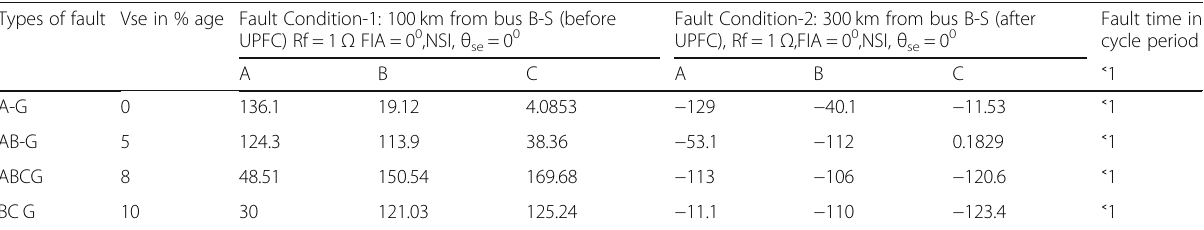
Table 4 DSE performance variation, fault time of variation in V se at θ se = 0 0 of UPFC Types of fault Vse in % age Fault Condition-1: 100 km from bus B-S (before UPFC) Rf = 1 Ω FIA = 0 0 ,NSI, θ se = 0